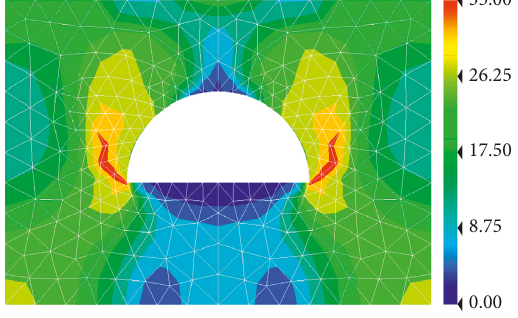
Figure 12: von Mises